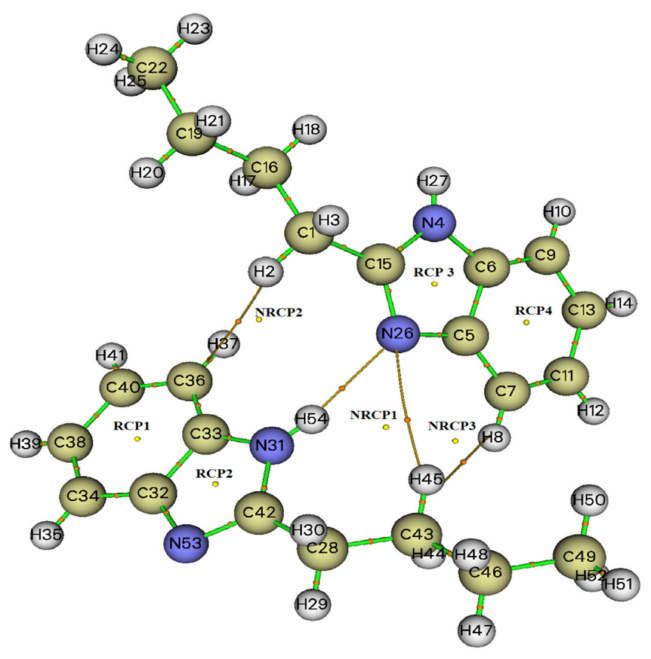
Figure 2. Molecular graph of the dimer.